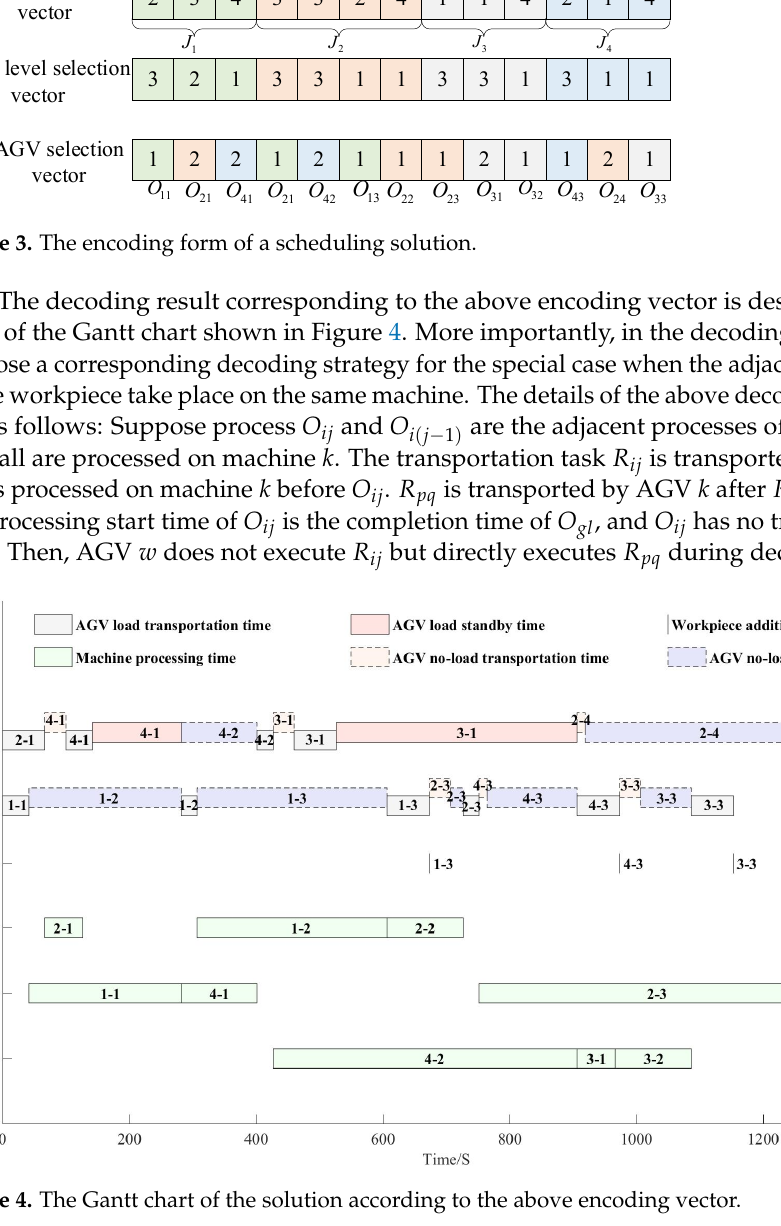
Figure 4. The Gantt chart of the solution according to the above encoding vector.